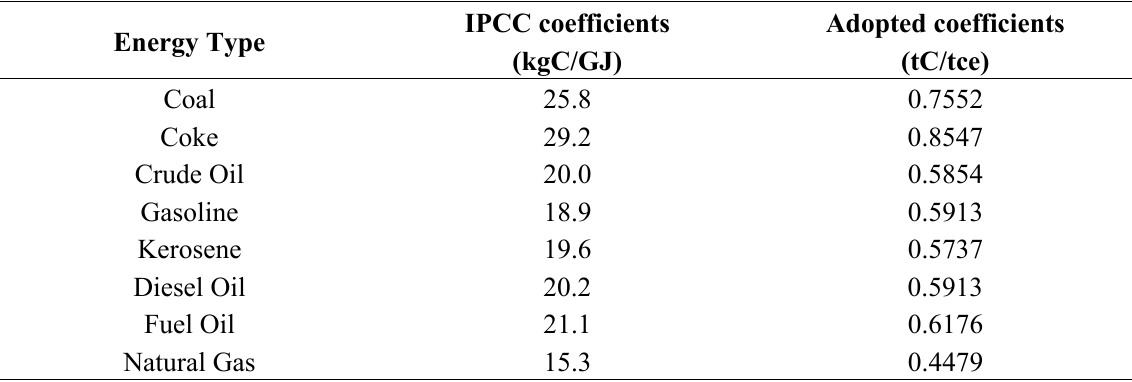
Table 1. The carbon emission coefficients of different energy resources. tce = ton of standard coal